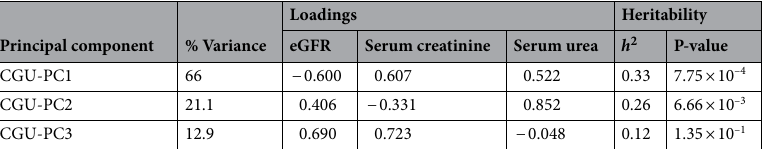
Table 1. Statistics of principal components extracted from eGFR, serum creatinine, and serum urea.